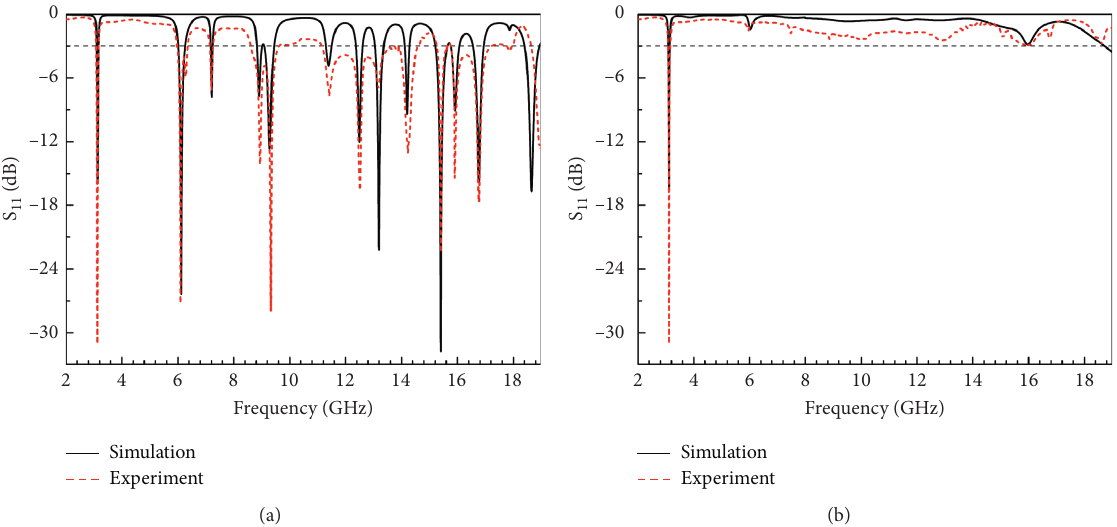
Figure 8: Simulated and measured S 11 of the conventional patch antenna and newly designed patch antenna: (a) conventional patch antenna; (b) newly designed patch antenna.